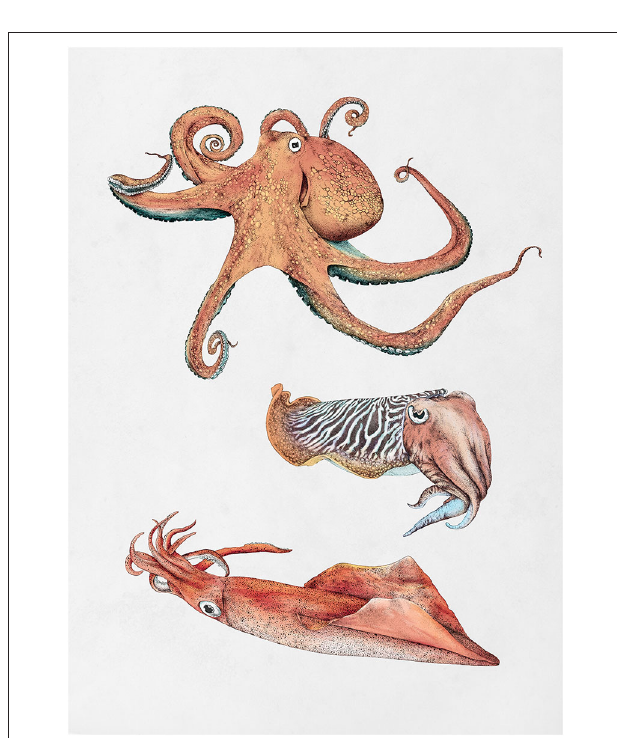
FIGURE 2 | Illustrations of the three most common classes of cephalopods that are used for eating: octopus, cuttlefish, and squid (Permission to reprint by Ene